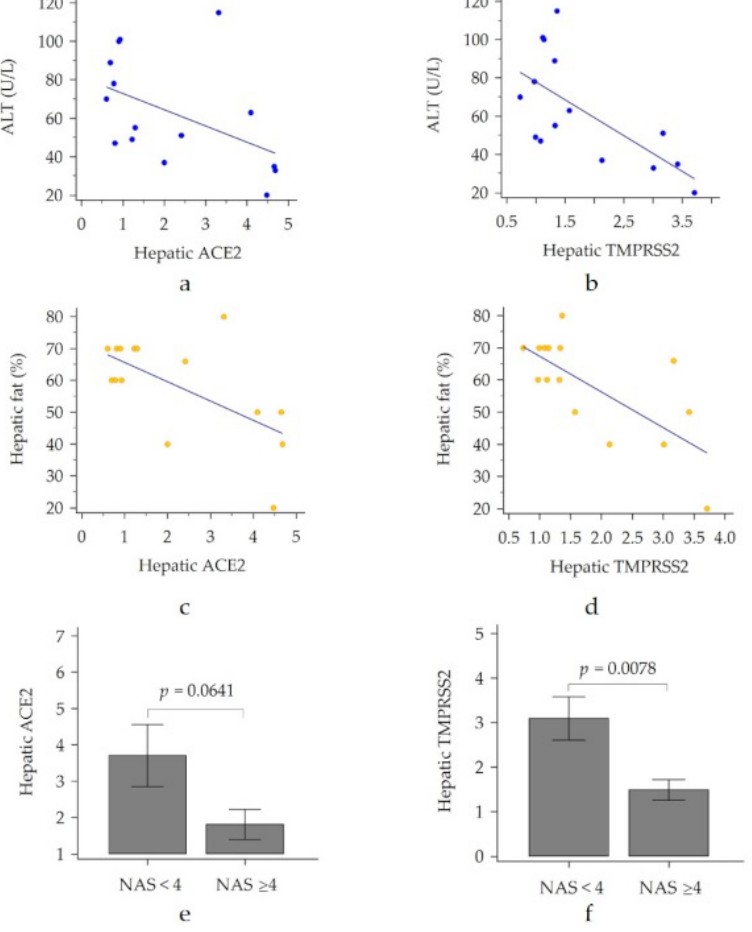
Figure 3. Hepatic ACE2 and TMPRSS2 according to the amount of steatosis ( a – d ) and to the degree of NAS score ( e , f ). ACE2, angiotensin converting enzyme 2; NAS, non-alcoholic fatty liver disease activity score; TMPRSS2, transmembrane serine pro-tease